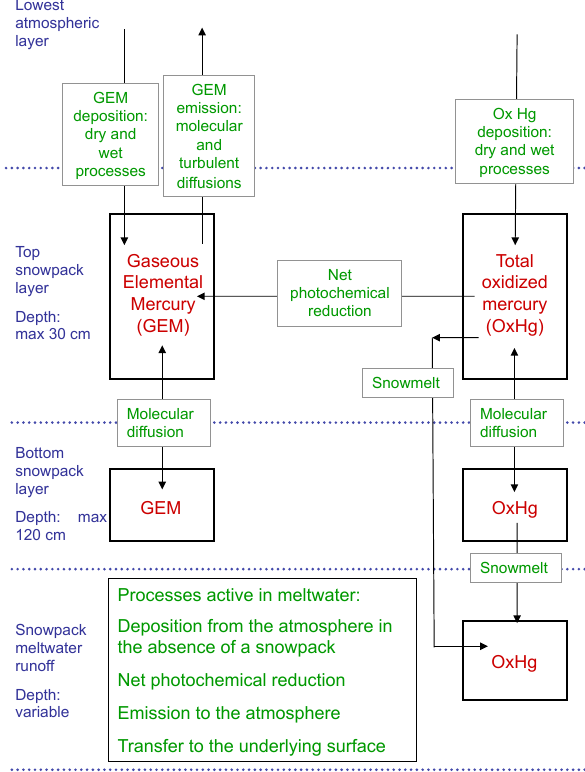
Fig. 1. A schematic of processes represented in the snow- pack/meltwater model for